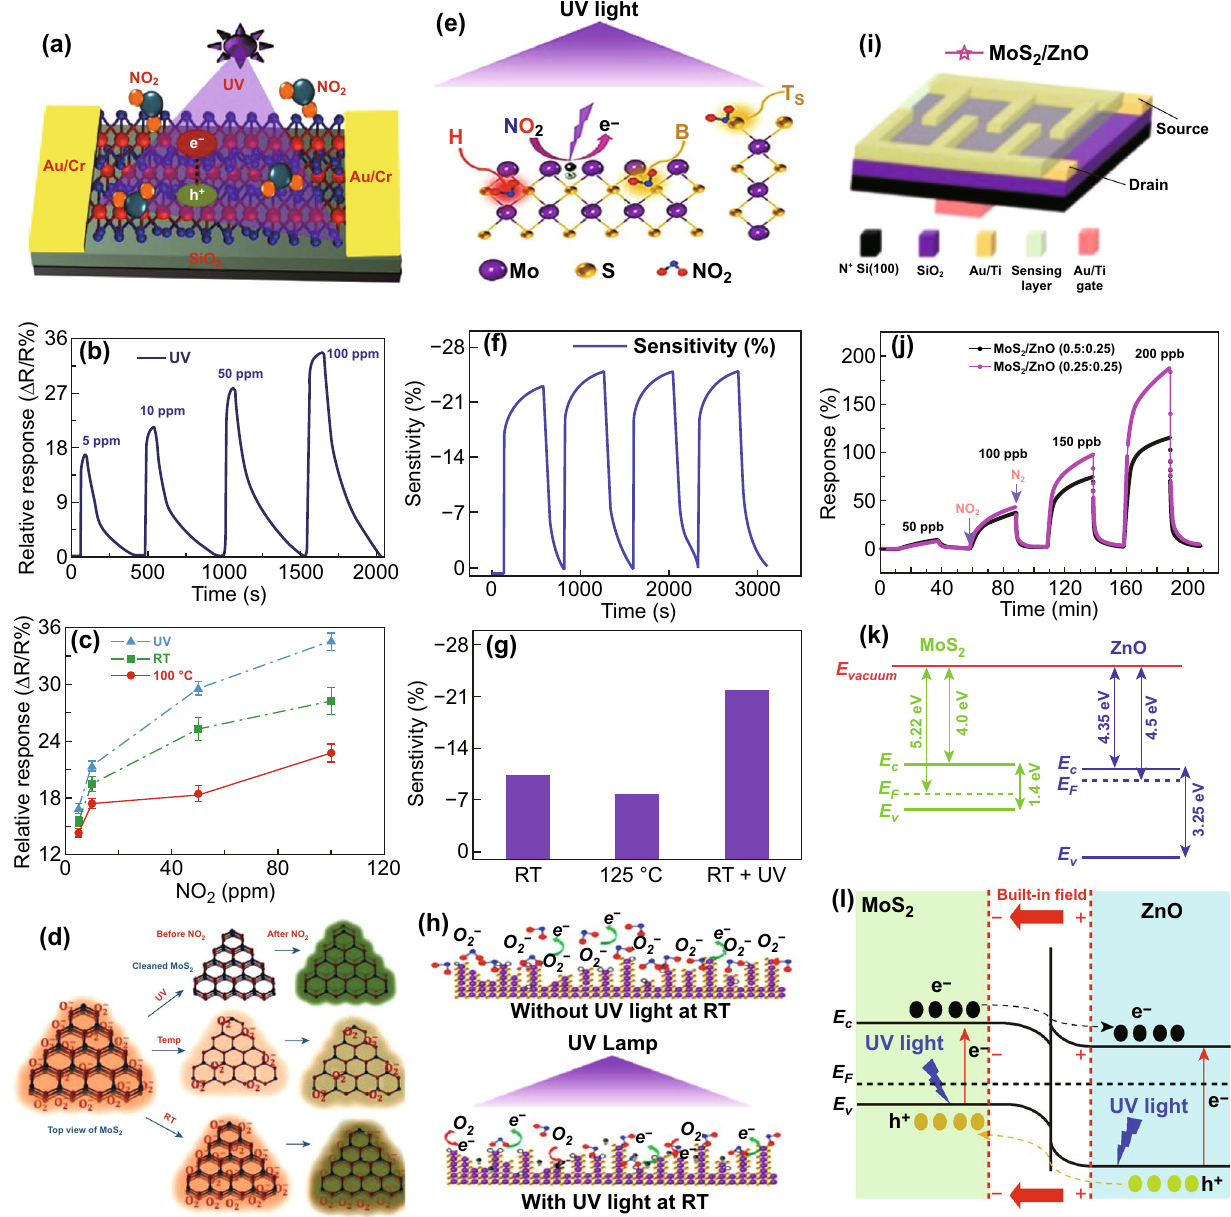
Fig. 16 a Schematic view of the proposed device under UV illumination. b NO 2 response under UV light, c comparative performance under UV at RT, RT, and at higher temperature. d Working mechanism. Reproduced with permission from Ref. [119]. Copyright (2017) American Chemical Society. e Proposed working mechanism under UV light. f Sensor response profile under UV light. g Comparative NO 2 sensing bar profile. h Working mechanism under UV illumination. Reproduced with permission from Ref. [120]. Copyright (2018) American Chemical Society. i Device schematic for NO 2 sensing. j NO 2 response with different concentration MoS 2 /ZnO composite device. k , l Band alignment before the junction and after the formation of contact with NO 2 exposure. Reproduced with permission from Ref. [325]. Copyright (2018)